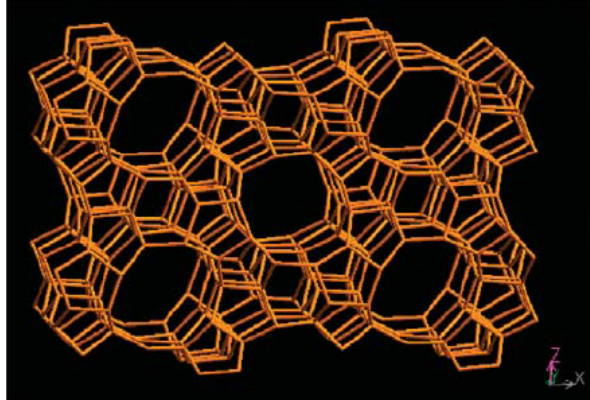
Figure 2: Zeolite structure of ZSM-5